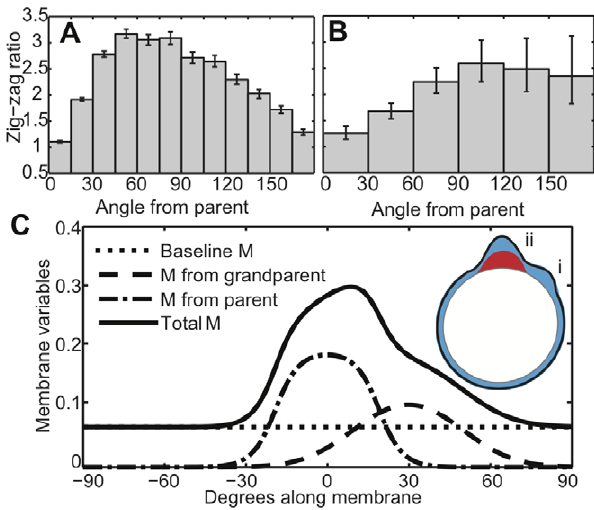
Figure 4. The zig-zag ratio increases with distance from the parent pseudopod. A) Simulated pseudopods are most likely to zig- zag when they extend at approximately a 90 u angle from their parent. The zig-zag ratio shown is the number of left-right or right-left sequences divided by the number of left-left or right-right sequences, and error bars indicate one standard error (see Methods). B) The zig-zag ratio for pseudopods detected in tracked cells is also largest when pseudopods form nearly perpendicularly from their parent. C) Simulated membrane variables after a constructed sequence of two pseudopods (inset). The first (i) formed at 30 u from 0–7 seconds, the second (ii) formed at 0 u from 11–18 seconds, and the variables are shown at 18.5 seconds. Units are as in Figure 1B. The different contributions to the total cortical memory (solid blue) are shown, including baseline memory (dotted), memory from the first pseudopod (dashed), and memory from the second pseudopod (dash-dotted).